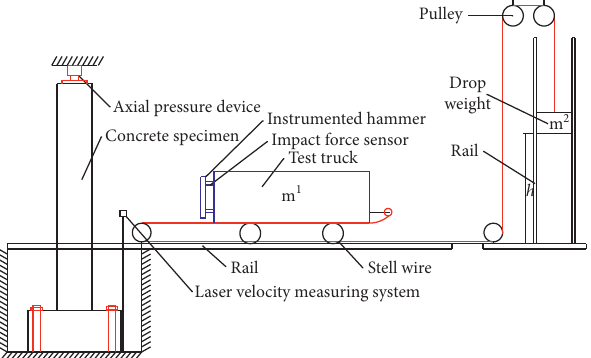
Figure 6: Multifunctional ultrahigh heavy drop hammer impact tester system.